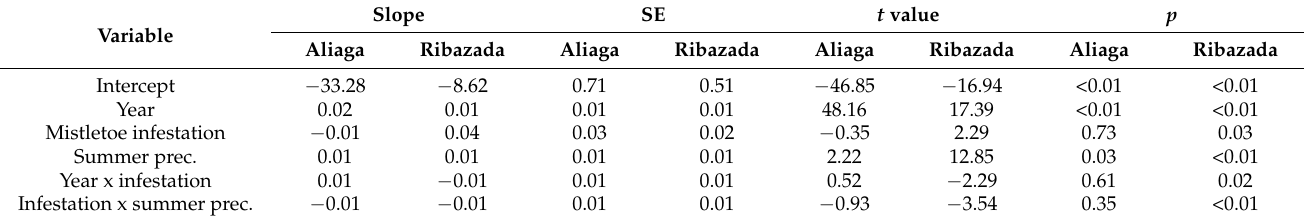
Infestation x summer prec.